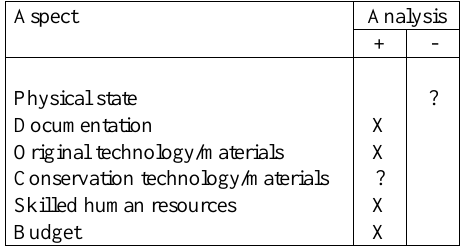
Table 1. Peterhof: restoration feasibility analysis